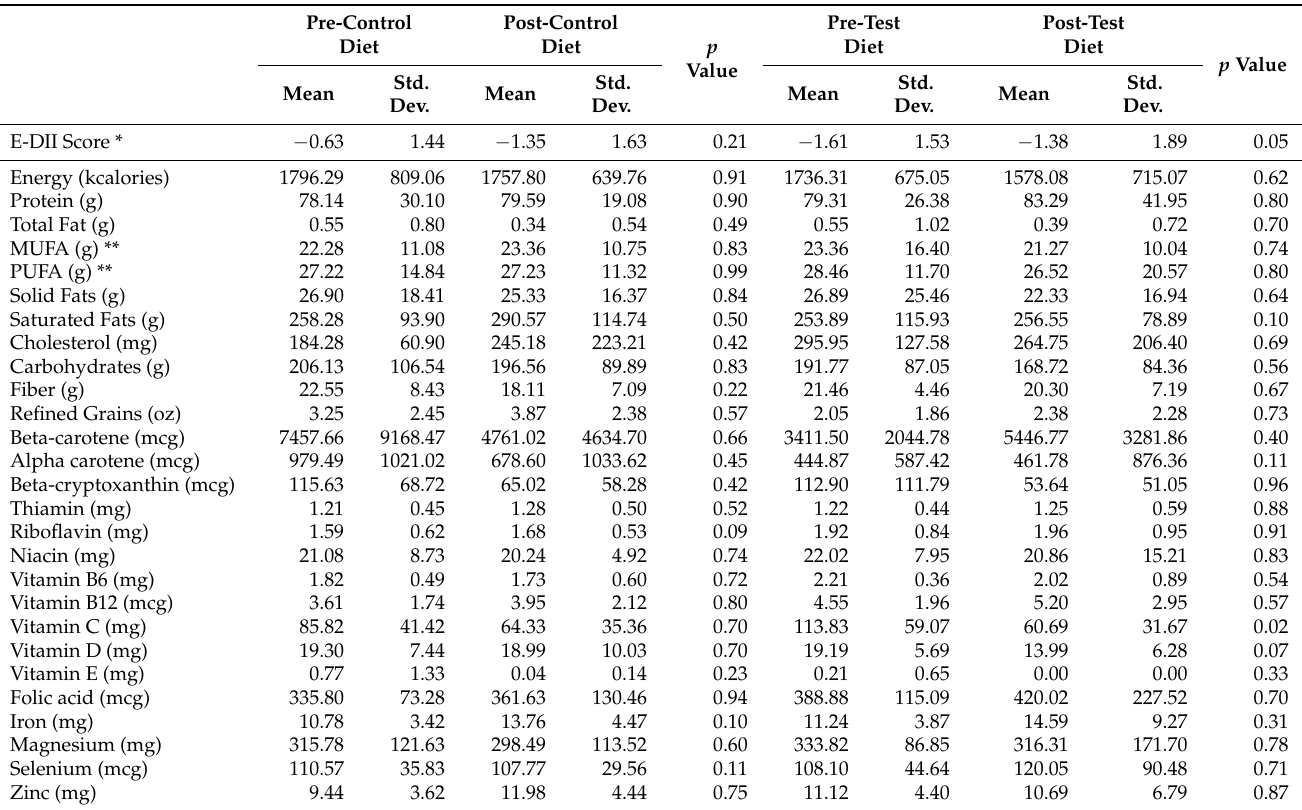
Table 4. Descriptive statistics and results of paired t-tests of dietary nutrient